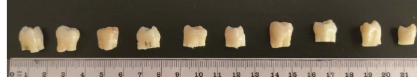
Figure 4: Pluriradicular teeth cut 2–5 mm from